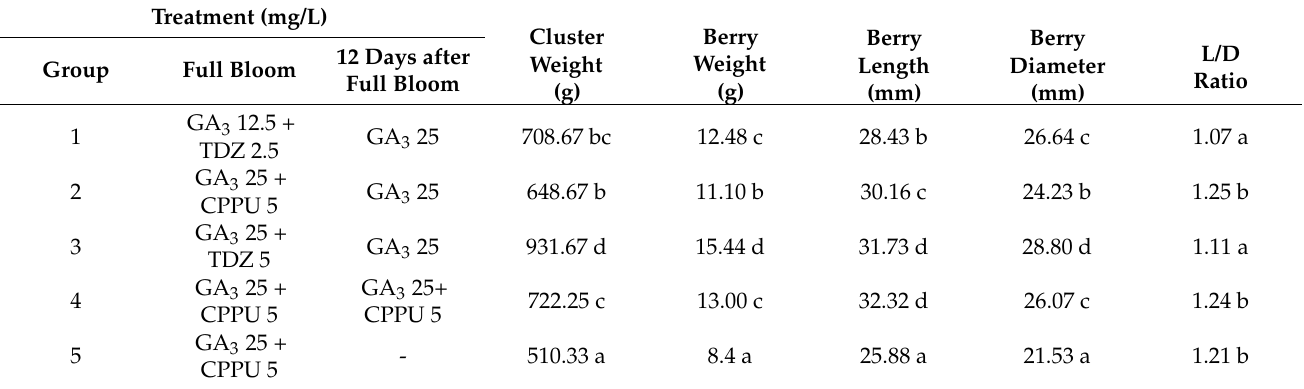
Table 2. Effects of gibberellic acid 3 (GA 3 ), thidiazuron (TDZ), and forchlorfenuron (CPPU) appli- cation on the fruit qualities of seedless ‘Shine Muscat’ grape at harvest.